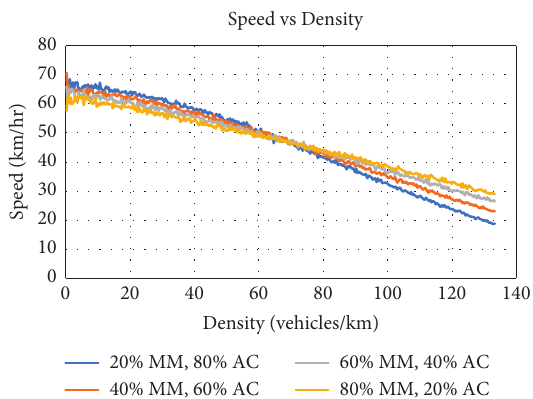
Figure 34: Flow rate vs. total no. of vehicles fundamental diagrams for different compositions of MM and AC.